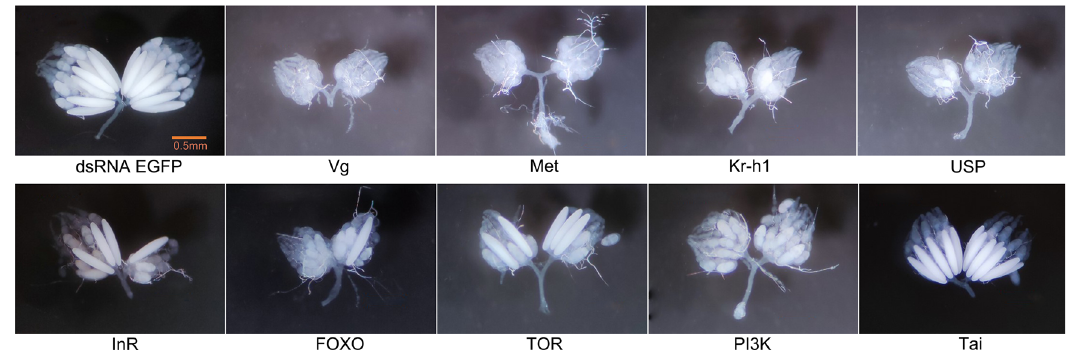
Fig. 6 Effects of RNAi knockdown of the Vitellogenin ( Vg ) and eight other genes involved in the JH, 20E and insulin-like peptide, signaling pathways, on ovarian development. The control group was treated with an equivalent dose of dsEGFP. Scale bar, 0.5 mm. Met , Kr-h1 and Tai are genes in the JH signaling pathway. InR , FOXO , TOR and PI3K are genes in the insulin signaling pathway. USP is gene in the 20E